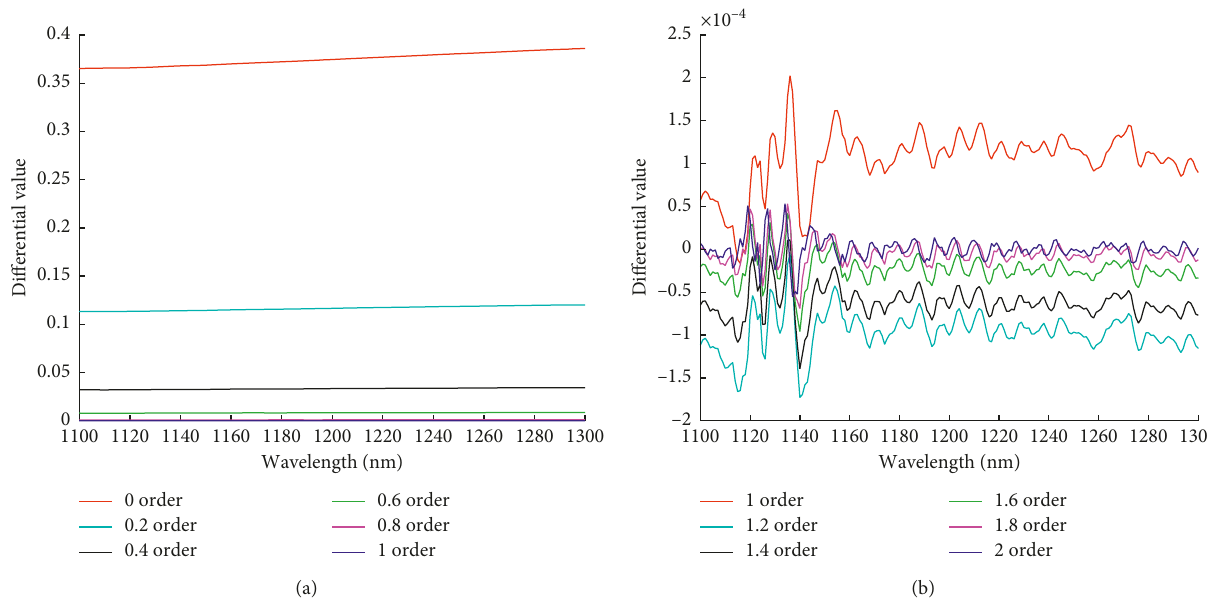
Figure 2: Fractional derivative value of reflectance at 1100nm–1300nm in the study area. (a) Zeroth order to first order; (b) first order to second